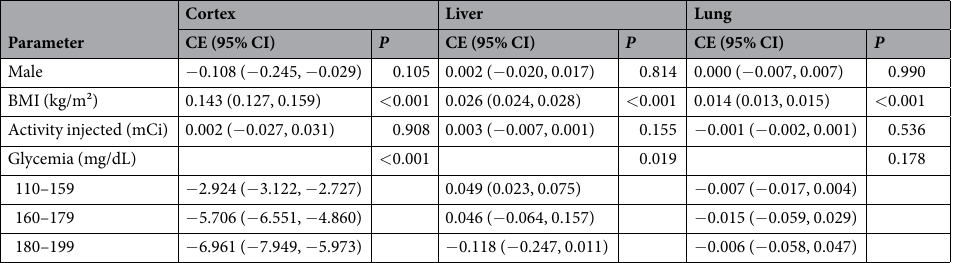
Table 3. Results of multivariate regression analysis of glycemia, adjusted for other factors affecting SUV. BMI = body mass index; CE = coefficient estimate; CI = confidence interval; SUV = standardized uptake value. All multivariate models were adjusted for sex, body mass index, activity injected, and fasting plasma glucose